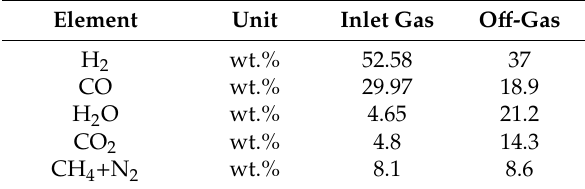
Table 1. Inlet gas and o ff -gas composition of Gilmore plant.